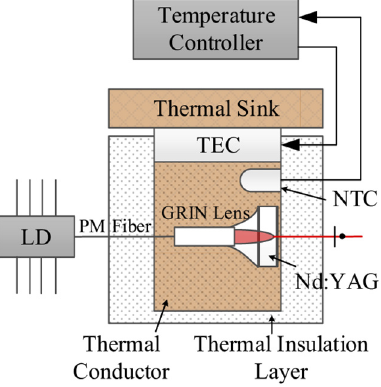
Figure 22. Schematic of microchip Nd:YAG dual-frequency laser [30]. LD: laser diode; TEC: thermo- electric cooler; NTC: negative-temperature-coefficient thermistor.